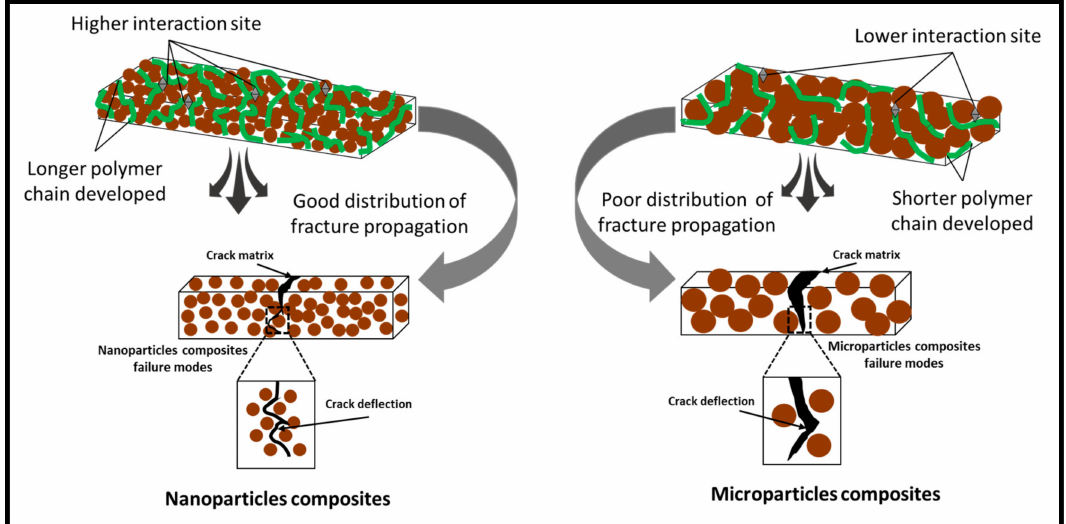
Figure 7. Schematic diagram of crystallite e ff ect on the mechanical properties of the coconut shell nanoparticle composite